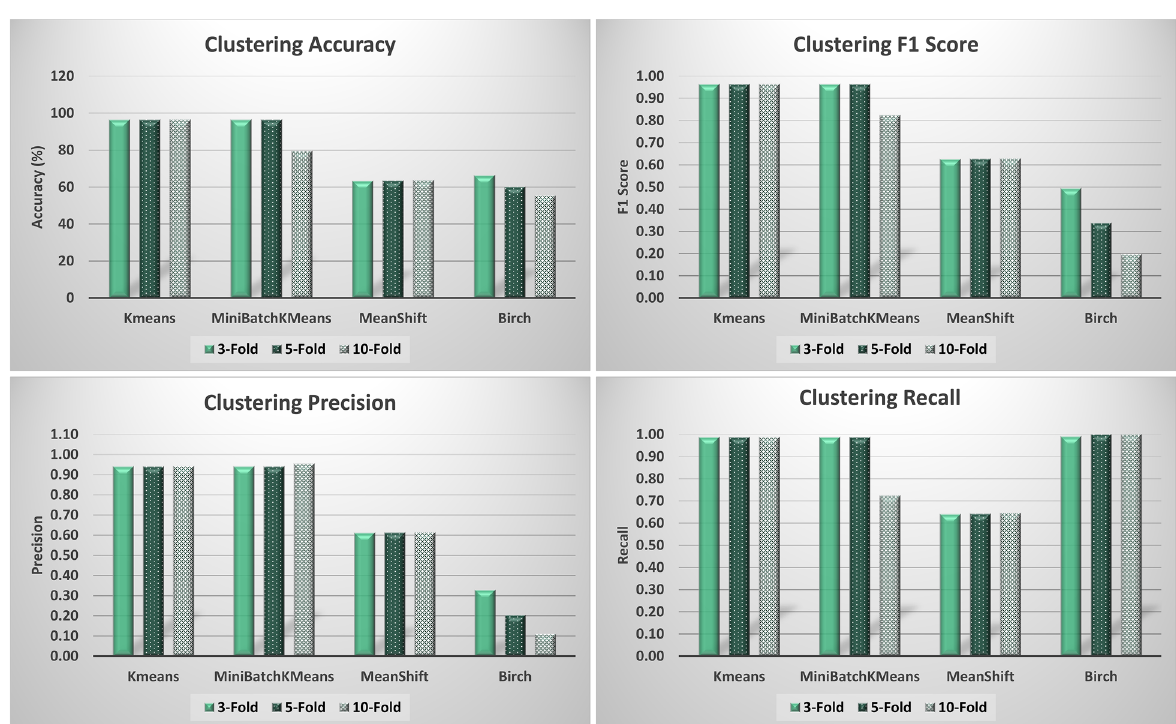
Fig. 9 Clustering performance